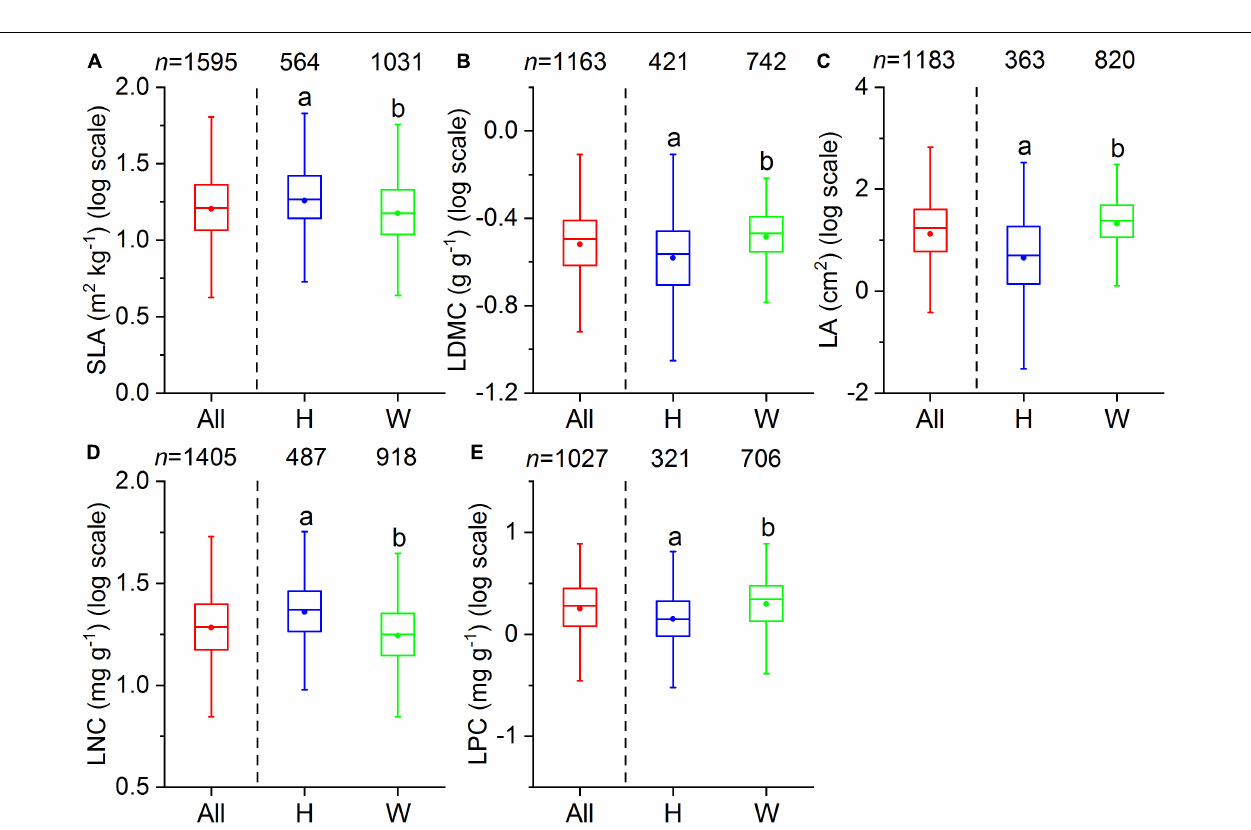
FIGURE 2 | Boxplots of leaf traits for all species (All), herbaceous species (H), and woody species (W). The number above each box indicates the total number of species per group. The bottom and top of the boxplots indicate the first and third quartile, the two whiskers correspond to the 1.5 times of the outliers, and the solid dots within the boxes are the mean values. Different lowercase letters indicate significant differences between herbaceous and woody species ( p < 0.05). (A) SLA, specific leaf area; (B) LDMC, leaf dry matter content; (C) LA, leaf area; (D) LNC, leaf N concentration; (E) LPC, leaf P concentration.